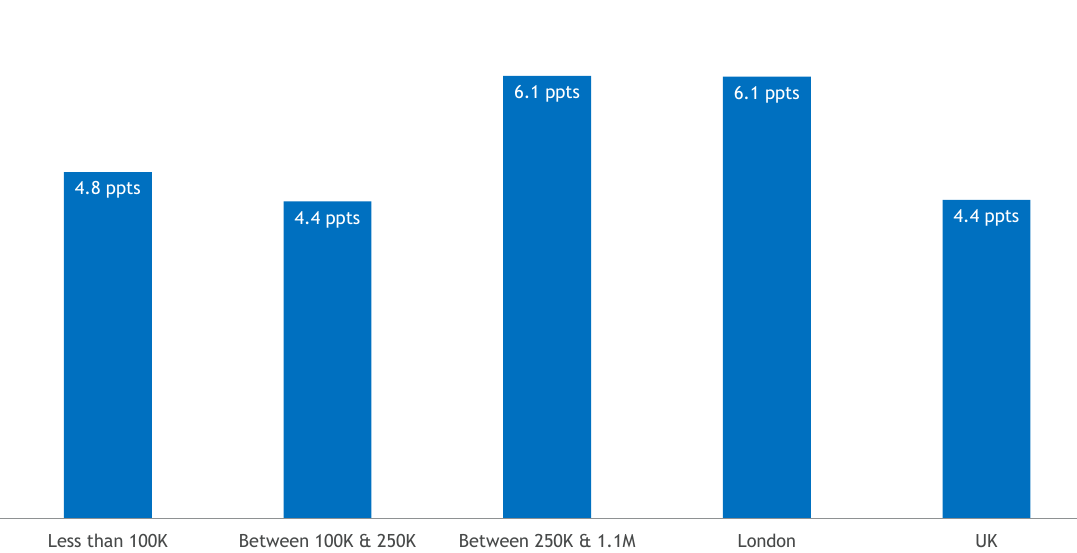
Figure 15: Larger urban areas have outperformed smaller ones Change in 16-64 year old employment rate in urban areas, by population size: